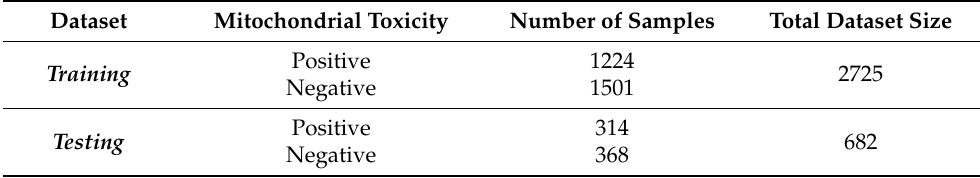
Table 1. Summary of the databases utilized in this study.